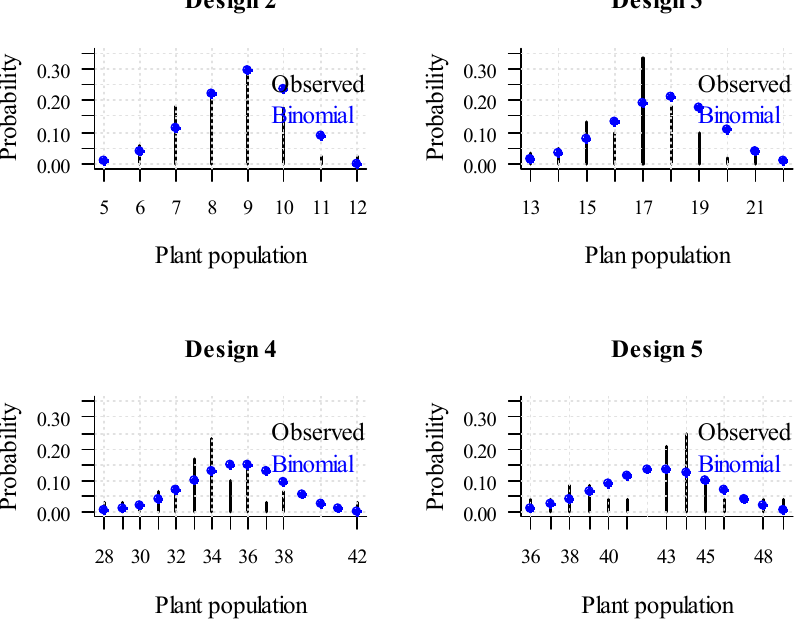
Figure 4. Binomial distribution of plant population in case of different mosaic sizes, 2017. Design codes of 2–5 represent the mosaics with the sizes of 1.5 m 2 , 3 m 2 , 6 m 2 , and 12 m 2 , respectively.